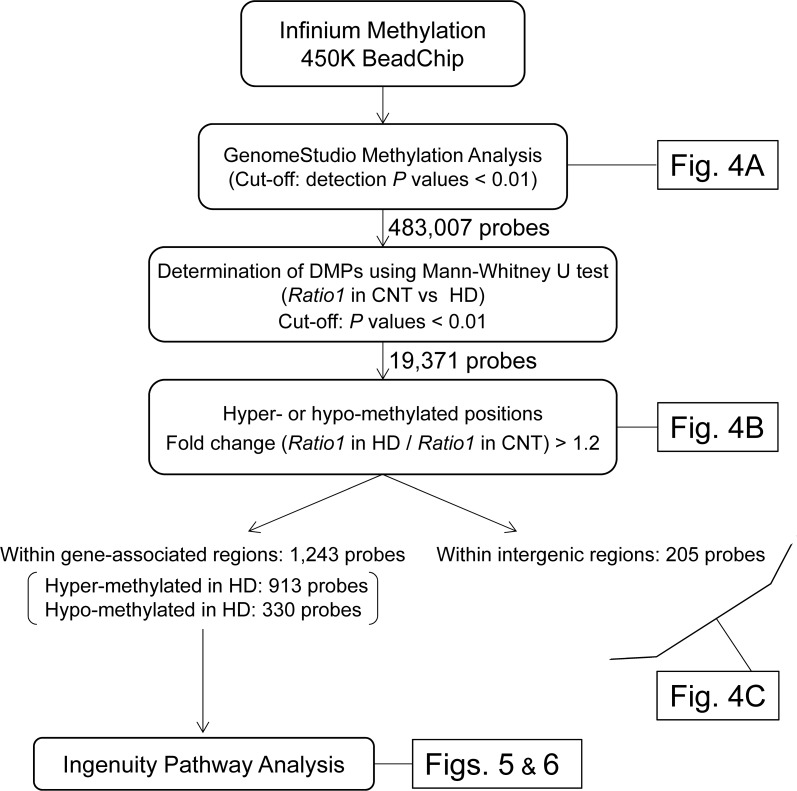
Flow chart diagram showing the genome-wide DNA methylation analysis.DMPs, differentially methylated CpG positions; Ratio1, the ratio of the β-value after training to that before training.